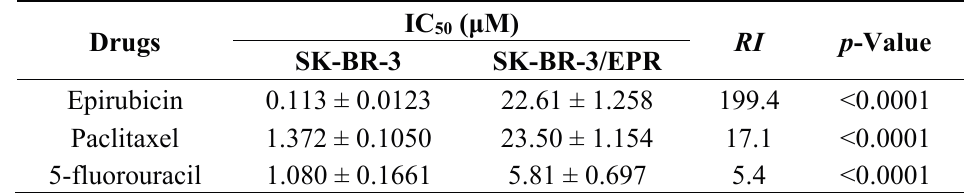
Table 1. IC 50 (the concentration of drug causing half inhibition of cell growth compared with the cell growth of the control group) values in parental SK-BR-3 and SK-BR-3/EPR to various chemotherapeutic